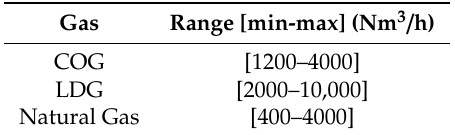
Table 5. Consumption ranges of the boiler gases.